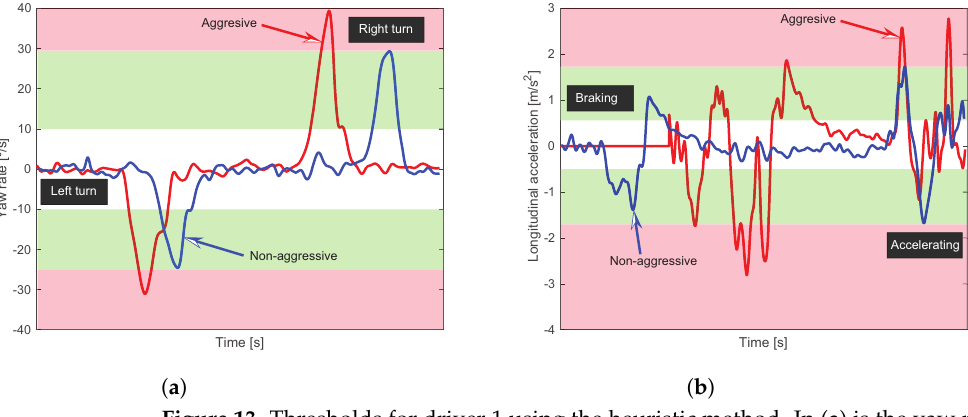
Figure 13. Thresholds for driver 1 using the heuristic method. In ( a ) is the yaw rate measurement when the vehicle turns on left and right and the driver style is aggressive and non-aggressive; in ( b ), the longitudinal acceleration in the braking and accelerating mode is presented, considering an aggressive and non-aggressive driving